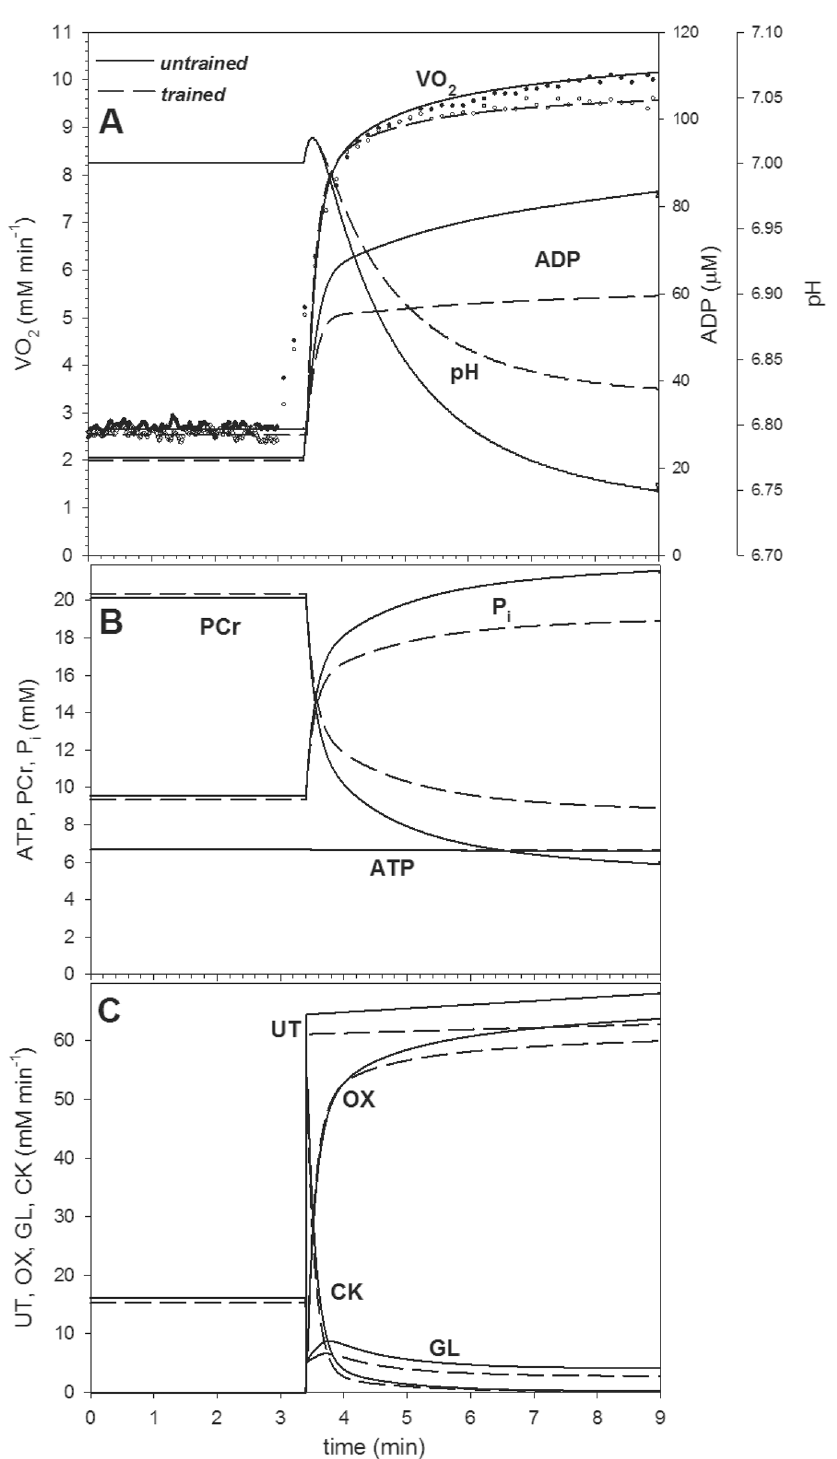
Fig 5. Experimental V ’ O 2 and simulated muscle V ’ O 2 , metabolite concentrations and ATP usage/ supply fluxes during low-intensity (baseline) and high-intensity cycling exercise in untrained and trained muscle. (A) Experimental and simulated V ’ O 2 , simulated ADP and pH. (B) Simulated PCr, P i and ATP. (C) Simulated ATP usage (UT), ATP supply by OXPHOS (OX), ATP supply by anaerobic glycolysis (GL), ATP supply by creatine kinase (CK). Experimental baseline-heavy-intensity exercise transition: after 3